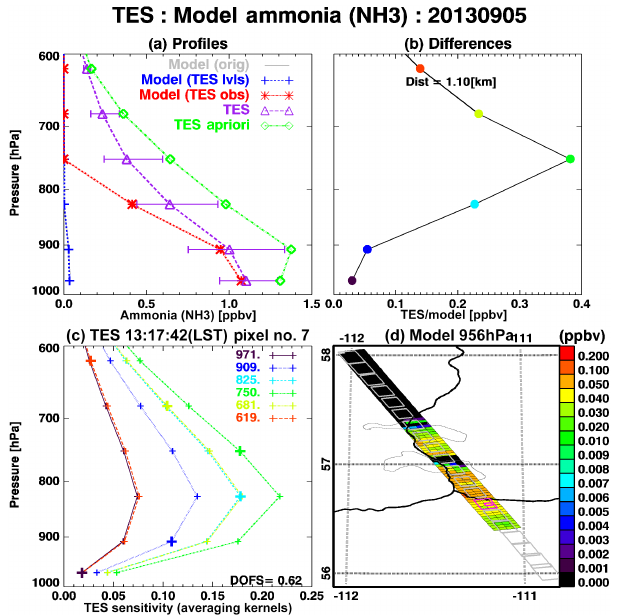
Figure 16. Summary box-and-whisker plots of the satellite and model comparisons during JOSM for NH 3 using the same plotting convention as Fig.